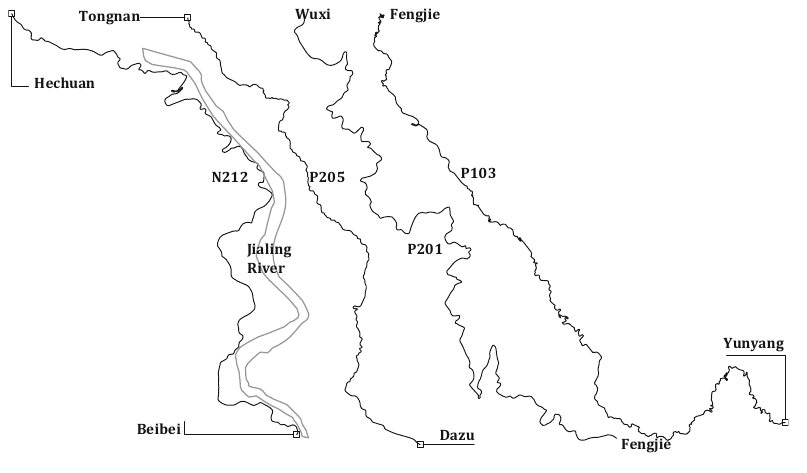
Fig. 2 The test route with complex alignment used in this